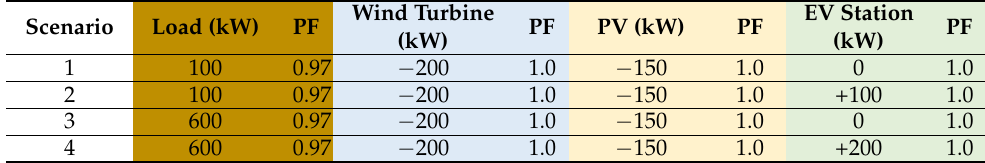
Table 4. Test set points for the use case